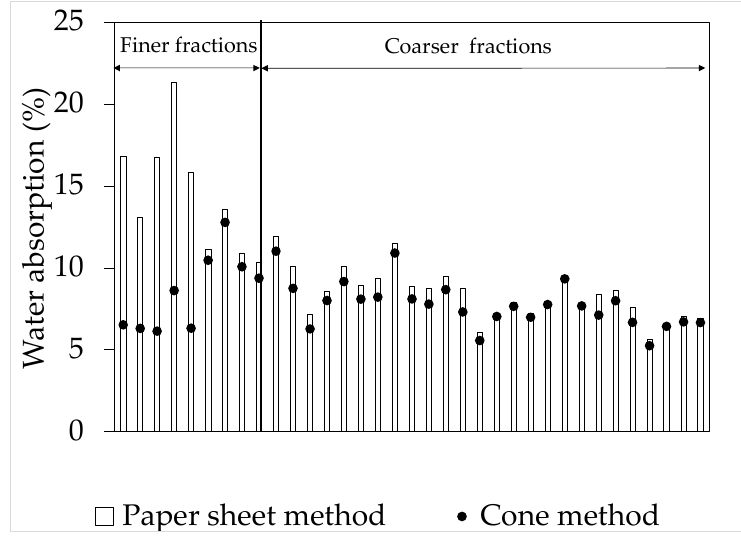
Figure 1. Water absorption capacities of differently sized fracstions of several FRAs [4 6 ].